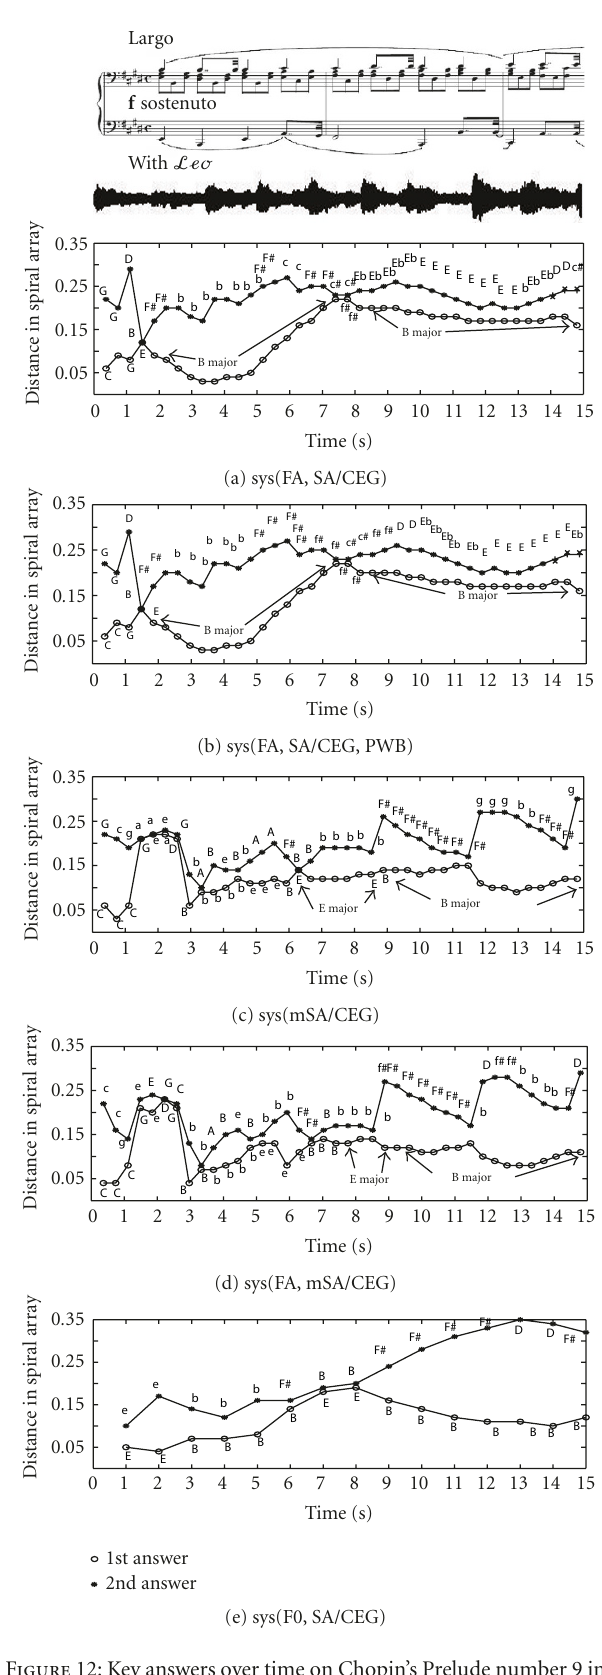
Figure 12: Key answers over time on Chopin’s Prelude number 9 in E